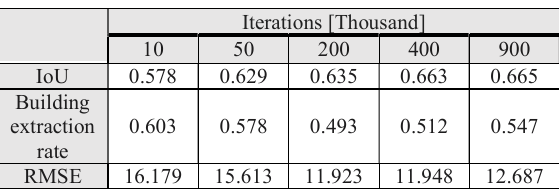
Table 1 . Relationship between iterations and accuracy